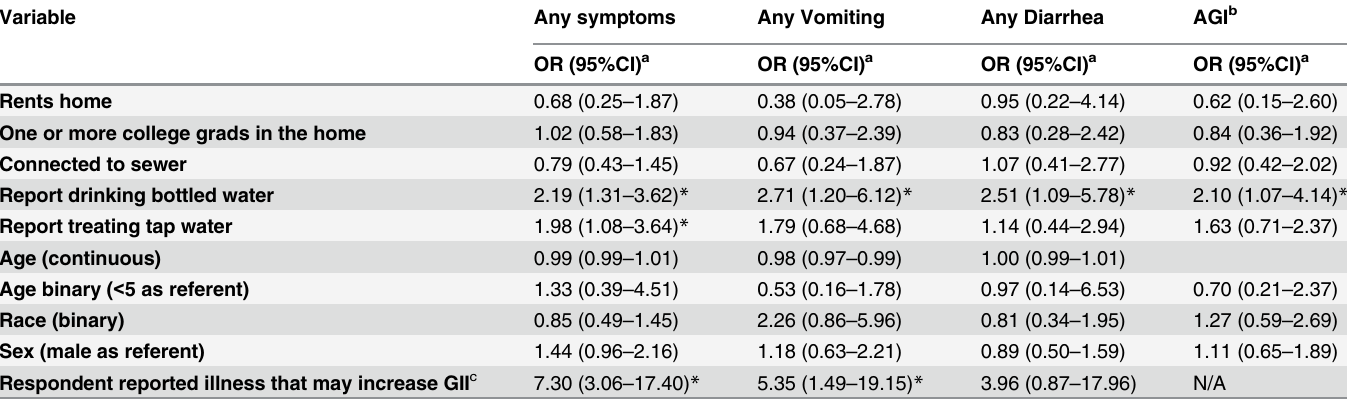
Table 4. Unadjusted Associations between Socio-demographic, Individual and Water Handling Characteristics and Reported Health Outcomes in a Cross-sectional Survey of Households in Rural Alabama in 2012.